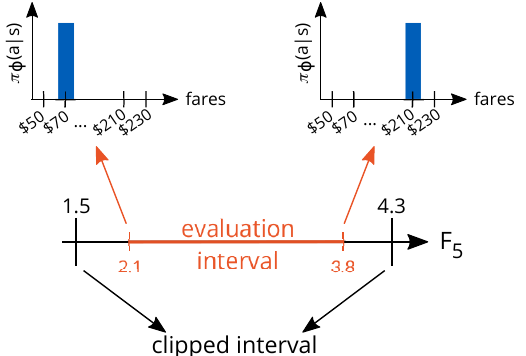
Figure 6. An illustration of the clipped and evaluation intervals and their corresponding revenue- maximizing